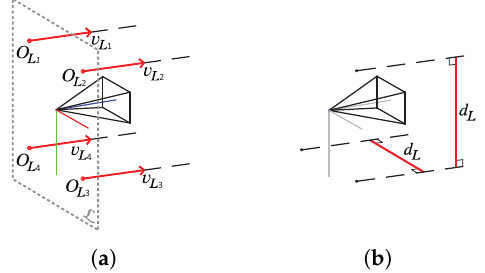
Figure 3. ( a ) Fully- and ( b ) partially-calibrated setup consisting of an optical camera and lasers, with the required information marked in red.